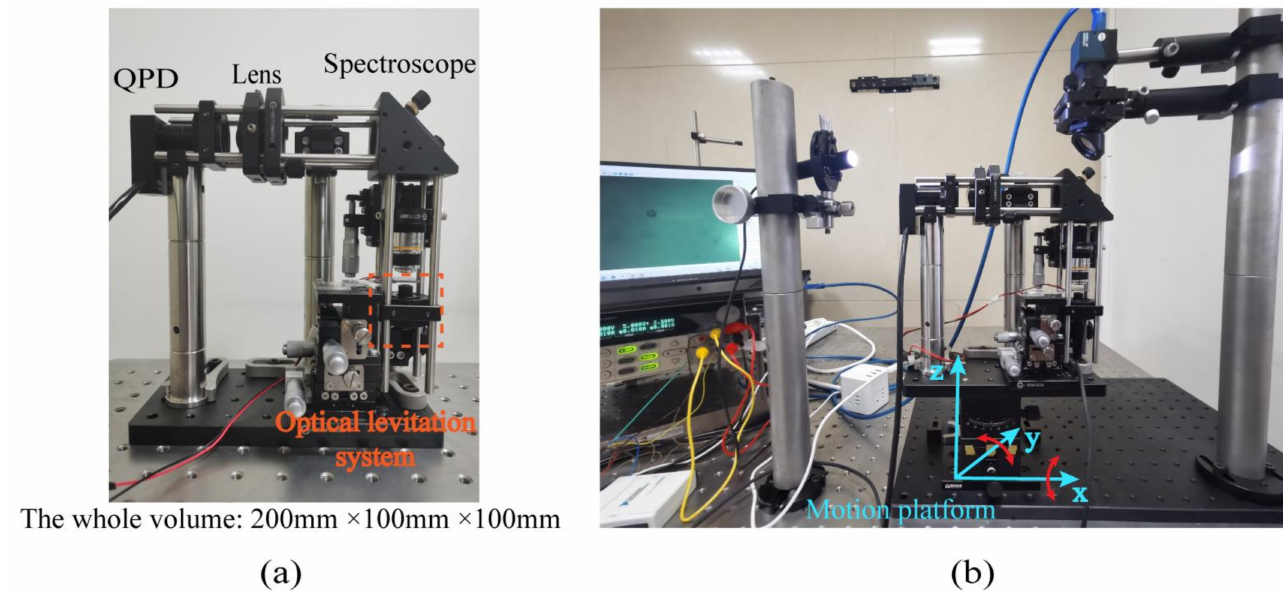
Figure 8. Photographs of the ( a ) accelerometer and the ( b ) test system.